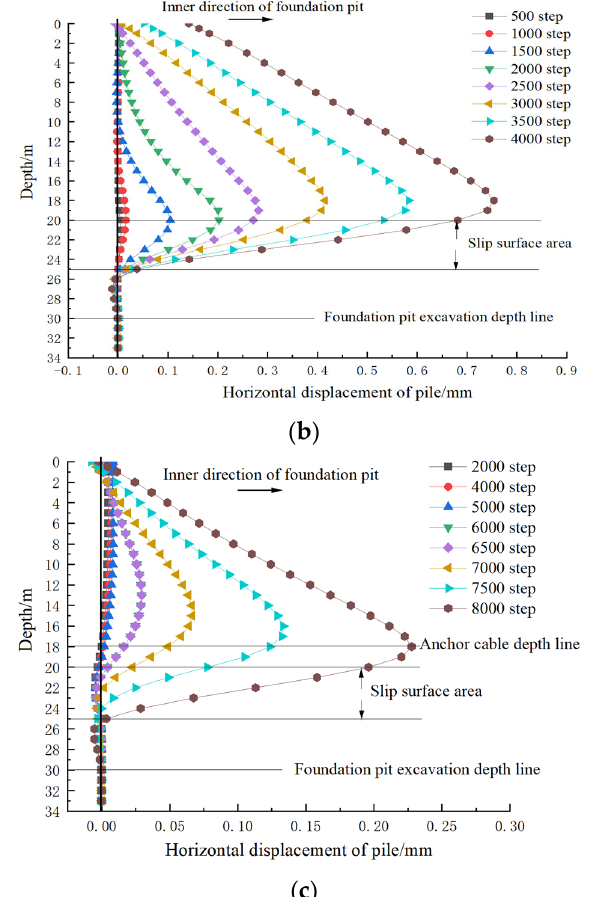
Figure 8. Displacement curve of pile body with 3.0 times pile spacing (2 piles). ( a ) The diameter of the cantilever pile is 0.8 m. ( b ) The pile diameter is 0.8 m and the crown beam is set. ( c ) The pile diameter is 0.8 m, and the crown beam and anchor cable are set.